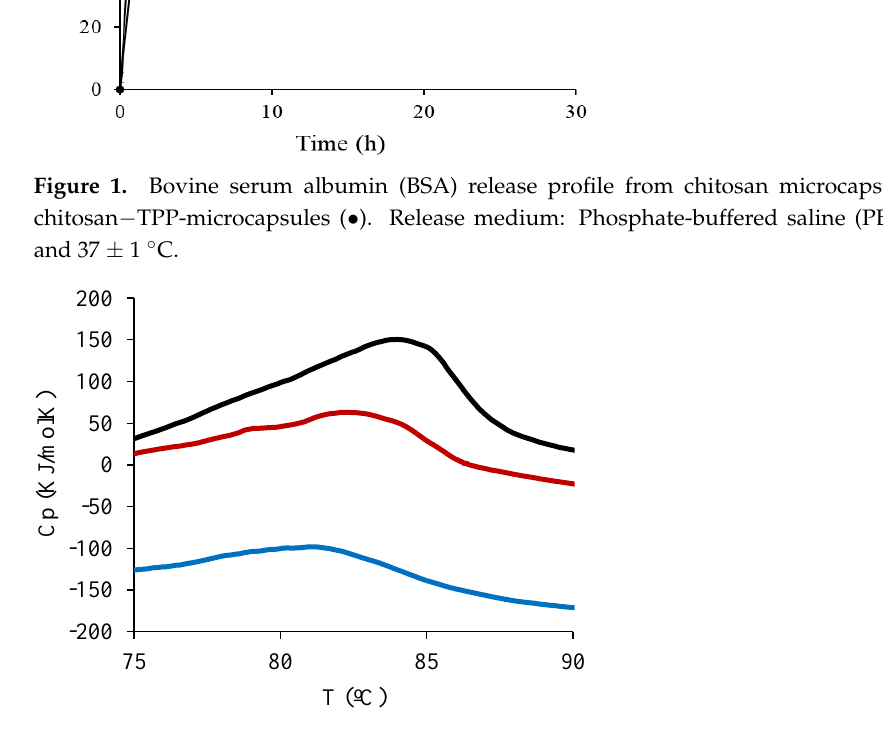
Figure 2. Thermograms of bovine serum albumin (BSA) samples representing the heat capacity (cp) versus heating temperature ( ◦ C) of native BSA (black line), BSA released from chitosan non-crosslinked microparticles (red line) and BSA released from chitosan − TPP crosslinked microparticles (blue line). TPP: tripolyphoshate.